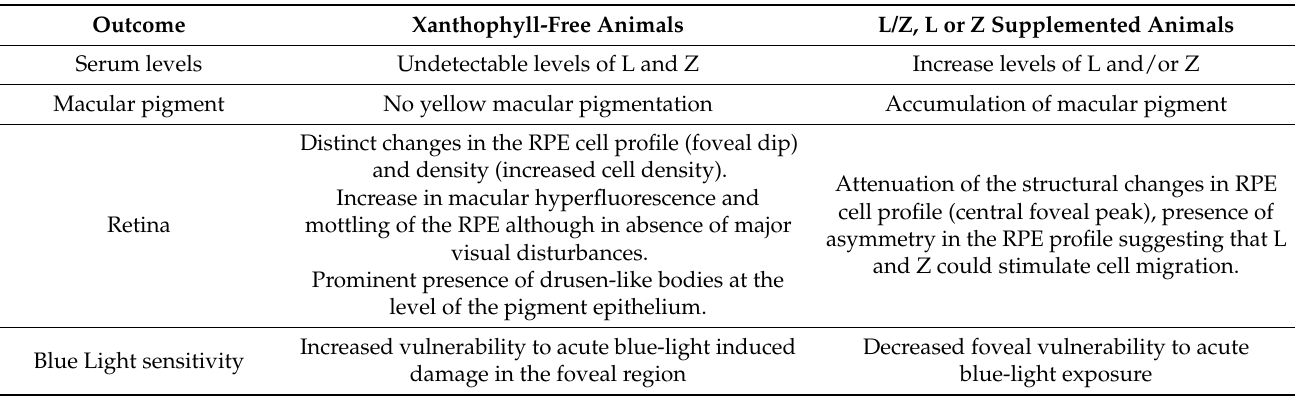
Increased vulnerability to acute blue-light induced Blue Light sensitivity damage in the foveal region